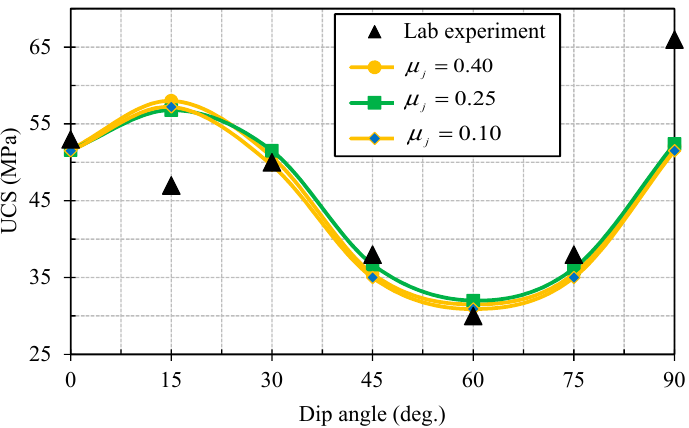
Figure 25. Strength variation of transversely isotropic rock samples with different joint coefficient of friction.